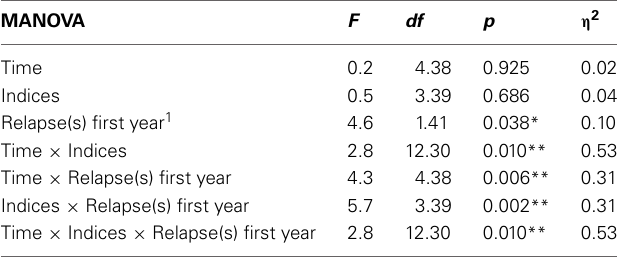
Table 3 | Results from MANOVA; effects of early relapse on neurocognitive indices over time.